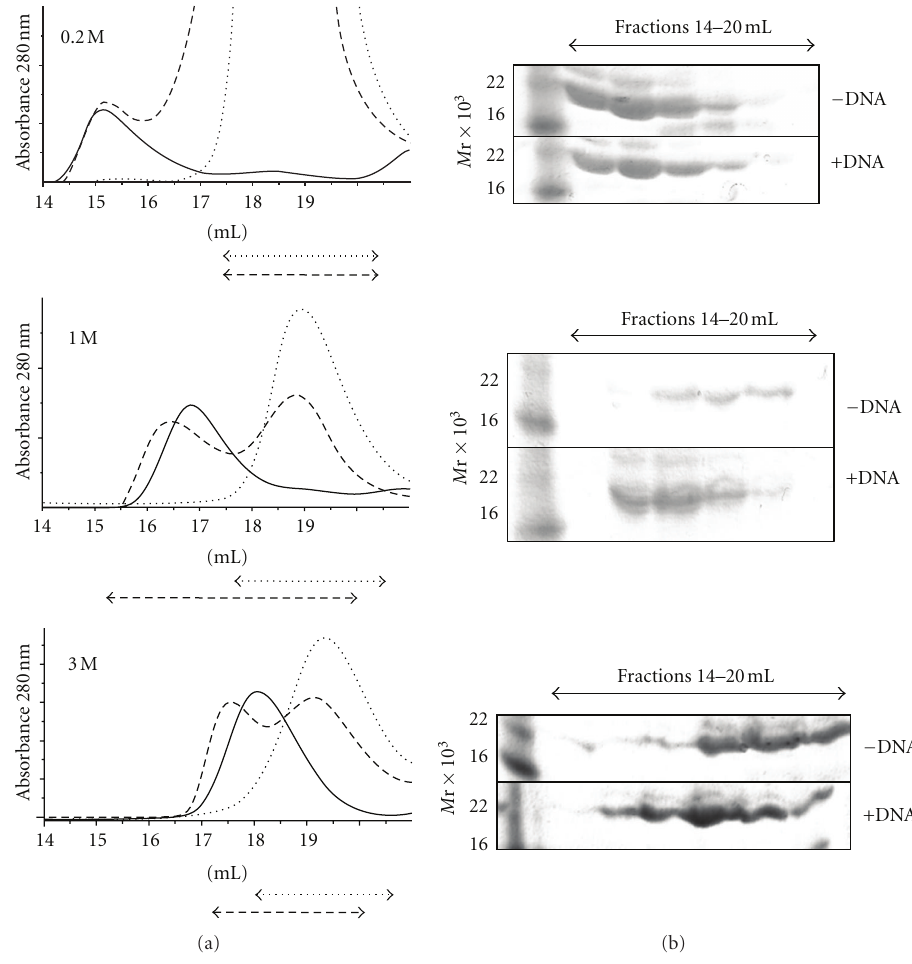
Figure 5: (a) Size exclusion profiles of HvRPA3-NTD in the presence (dashed line) and absence (solid line) of equimolar 18mer ssDNA in 0.2, 1, and 3 M KCl. The elution profile of the oligonucleotide alone is shown (dotted line). The x axis shows elution volume (mls) and the y axis absorbance at 280 nm. For clarity the peaks containing protein and protein/oligonucleotide have been scaled relative to the oligonucleotide alone. Peak heights (mAu) were 0.2 M 6.2/6.7, 1M 7.4/40.5, and 3M 10.1/59.3 (NTD alone/NTD+18mer ssDNA). Arrows indicate the presence of ssDNA in complex (dotted line) and alone (dashed line). (b) SDS-PAGE analysis of the indicated fractions in the presence and absence of oligonucleotide. Increased salt concentrations induce a degree of warping in the